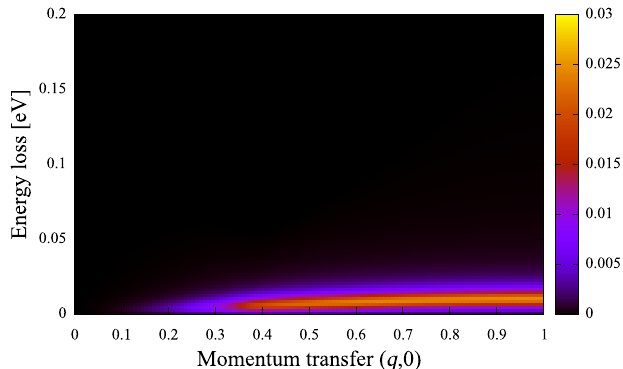
FIG. 4. Longitudinal acoustic phonon contribution to RIXS. Momentum transfer is given in units of π =a .